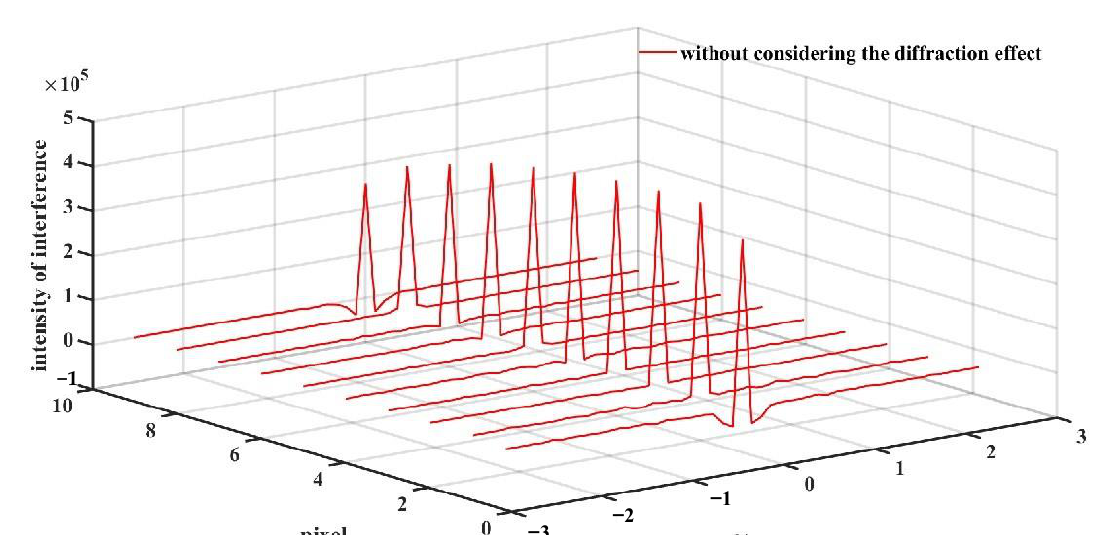
Figure 8. Interferogram without considering the diffraction effect.